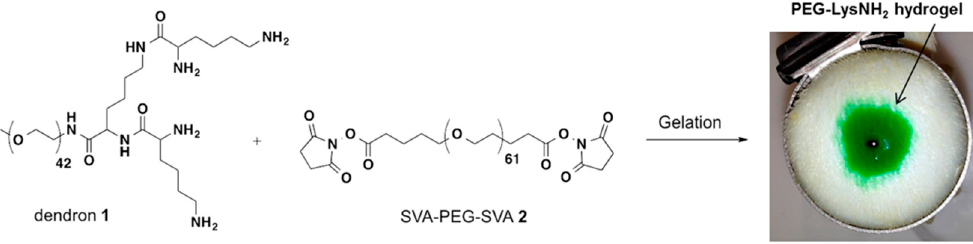
Figure 15. In situ formation of PEG-Lys-NH 2 -based hydrogel for sealing small corneal incisions. Reproduced from [40]; published by the BioMed Central.